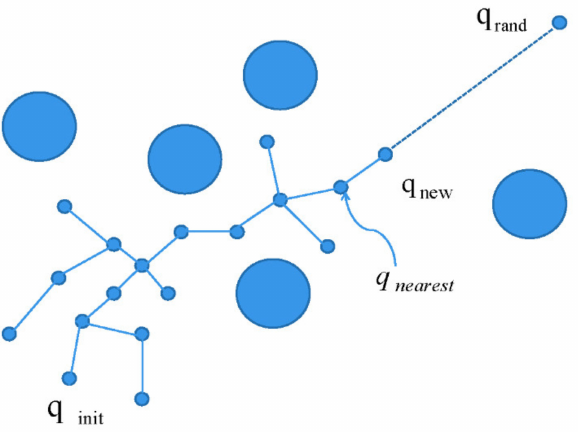
Figure 2. Classic RRT mind